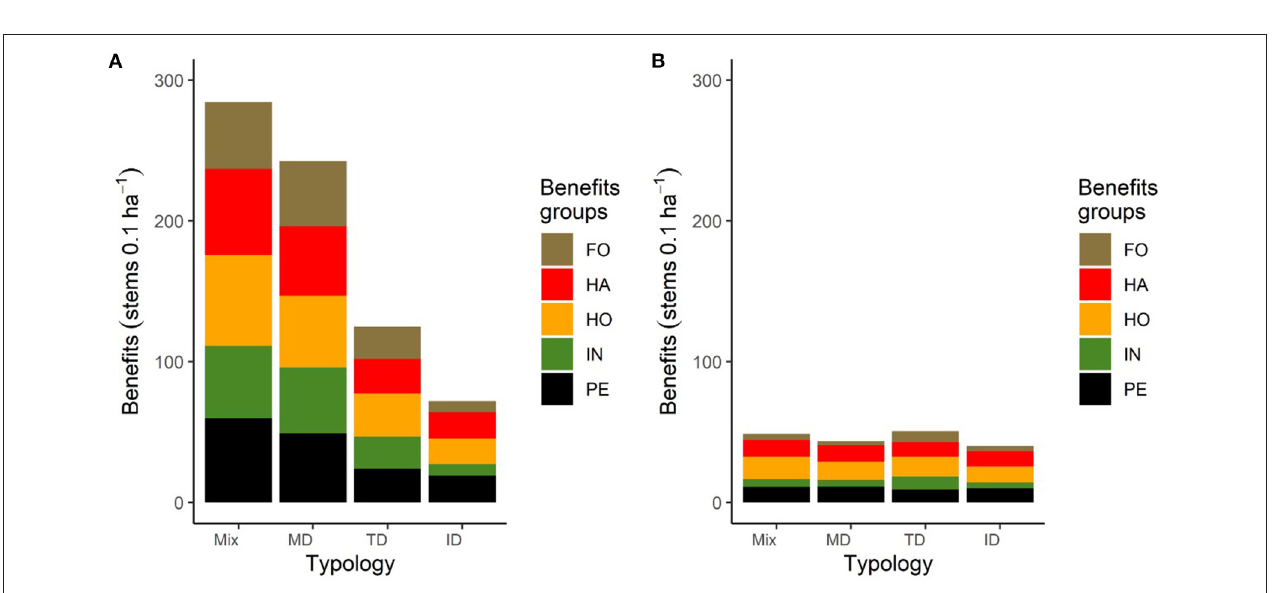
FIGURE 4 | Average benefits from the agroforestry system types, including (A) and excluding (B) banana stems. FO, Food; HA, Habitat; HO, Other household use; IN, Income; PE, Productivity enhancement